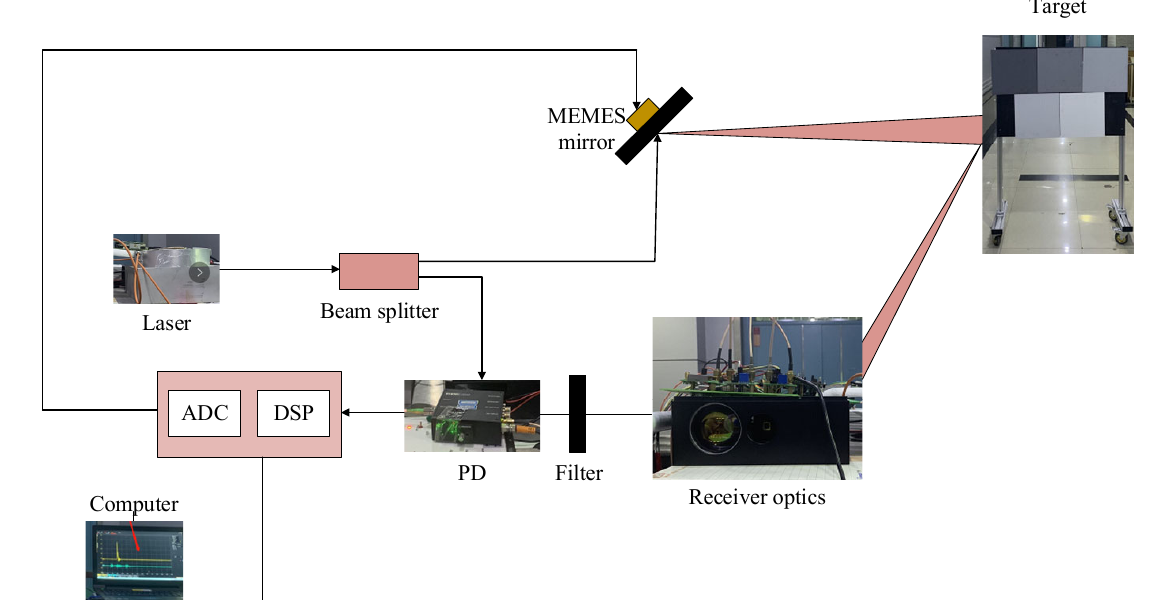
Figure 4. Principle diagram of the pulse Lidar ranging system. ADC is analog to digital converter, DSP is digital signal processing. Table 2. Specifications of the Lidar system.